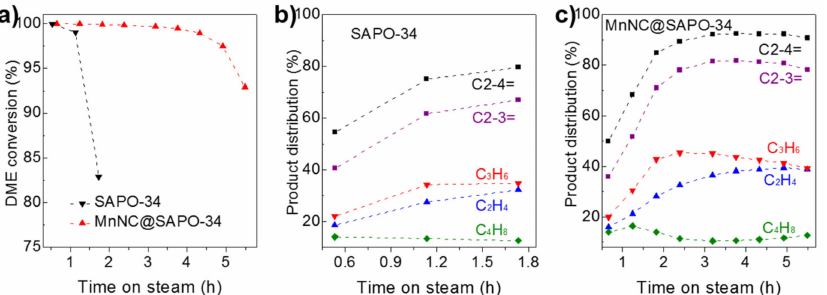
Figure 6. ( a ) Catalytic activity, based on dimethylether (DME) conversion, over the SAPO-34 silicoa- luminaphosphates and MnNC@SAPO-34 catalysts in the dimethyl ether to olefins (DTO) process. Product distribution (selectivity for light olefins of C2-4=, C2-3=, C 2 H 4 , C 3 H 6 , and C 4 H 8 ) catalyzed on the ( b ) SAPO-34 and ( c ) MnNC@SAPO-34. Reaction conditions: 1.5 MPa (14.4 v % DME, 30.6 v % H 2 , 55.0 v % N 2 ), GHSV = 3000 mL g − 1 h − 1 , 150 mg catalyst, 350 ◦